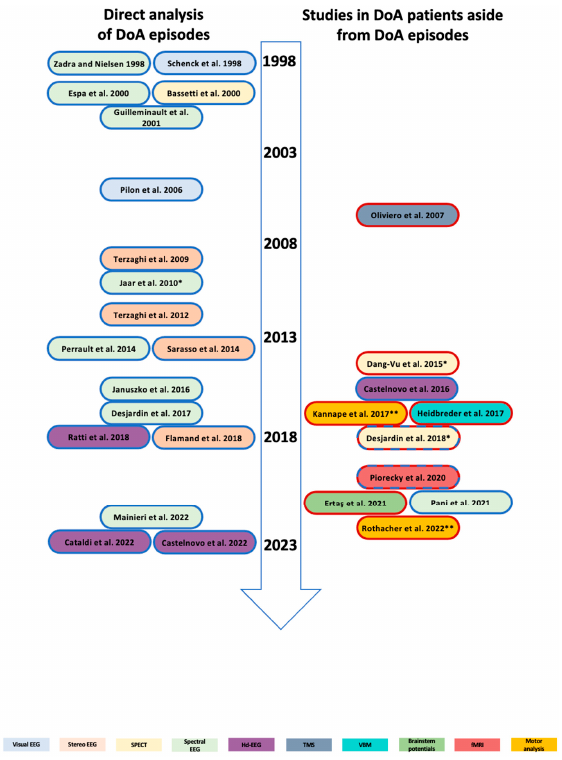
Figure 1. Neurophysiologic studies in DoA. On the left, neurophysiologic studies directly analyzing DoA episodes are illustrated [15–20,22–26,30,32,34,36,40–42]. On the right are neurophysiologic studies that analyzed DoA patients independently of the episodes (nocturnal sleep detached from DoA episodes/wakefulness) [21,27,29,31,33,35,37,38,43,44]. Listed studies are circled by either blue or red discs, respectively indicating if performed during sleep or wakefulness. “*” and “**”, respectively, indicate studies performed under sleep deprivation or with a specific cognitive load. Studies are illustrated in chronological order. Below: legend of the different neurophysiological methods used in the listed studies, indicated by different colors. Abbreviations: EEG, electroencephalogram; SPECT, single-photon emission computed tomography; Hd, high density; TMS, transcranial mag- netic stimulation; VBM, voxel-based morphometry; fMRI, functional magnetic resonance imaging. 2. Methods Narrative literature research has been performed on Pubmed and Scopus research databases, with no restriction on articles’ publication date. Published papers up to Sep- tember 2022 were included. We used the following keywords: “NREM parasomnias” AND (“adults” or “violence”), “disorders of arousal” AND (“adults” or “violence”), NREM parasomnias” AND (“diurnal impairment”), “sleep-related violence”, “confu- sional arousal” AND (“adults” or “violence”), “sleep terror” AND (“adults” or